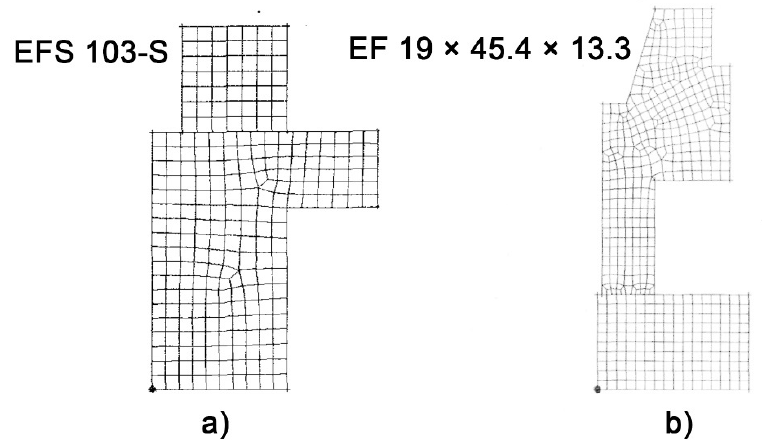
Figure 7. FEM final simplified models use in the simulation.